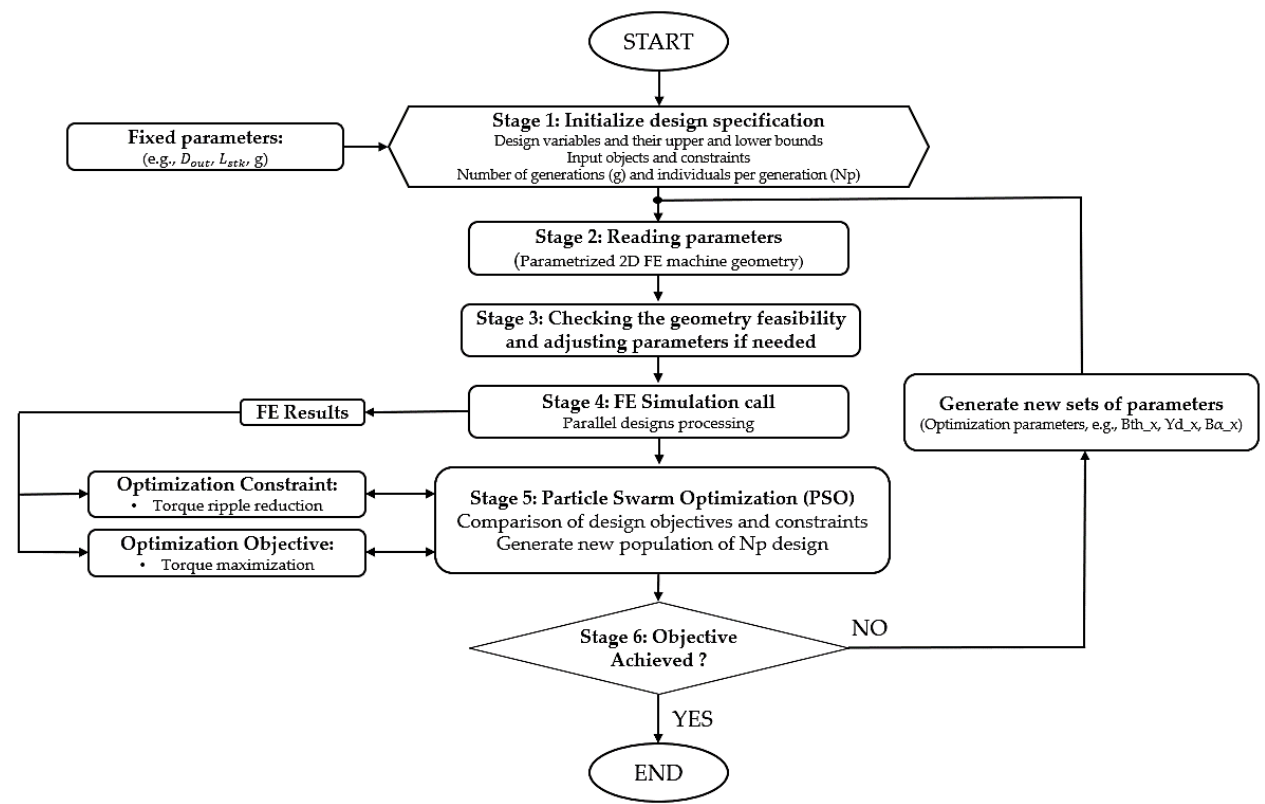
Figure 1. FE-based electromagnetic optimization workflow for the SynRM studied in [6].